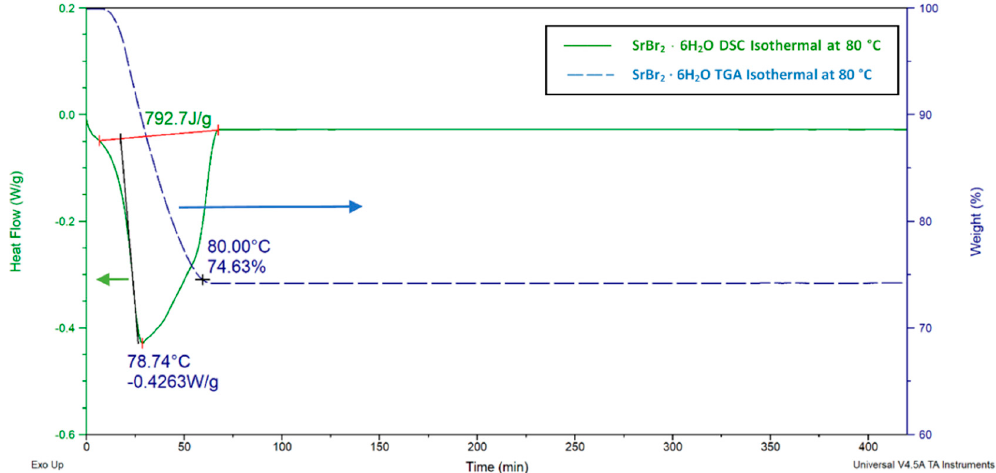
Figure 17. SrBr 2 ⋅ 6H 2 O isothermal TGA and DSC charts. For DSC, a 3 °C ⋅ min − 1 heating rate and a 20 ml ⋅ min − 1 N 2 flow rate were adopted, and the sample was held isothermal at 80 °C for 420 minutes. For, the TGA test, the sample was heated at a 3 °C ⋅ min − 1 heating rate and stayed isothermal at 80 °C for 420 minutes.